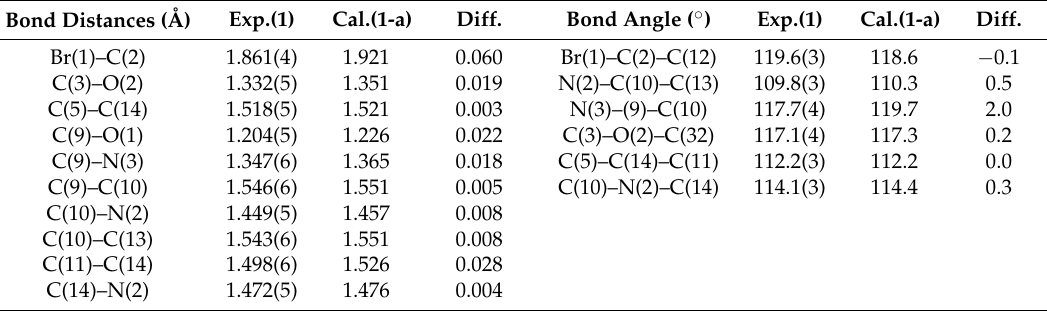
Table 4. Selected experimental and calculated geometry parameters for compound 1 .